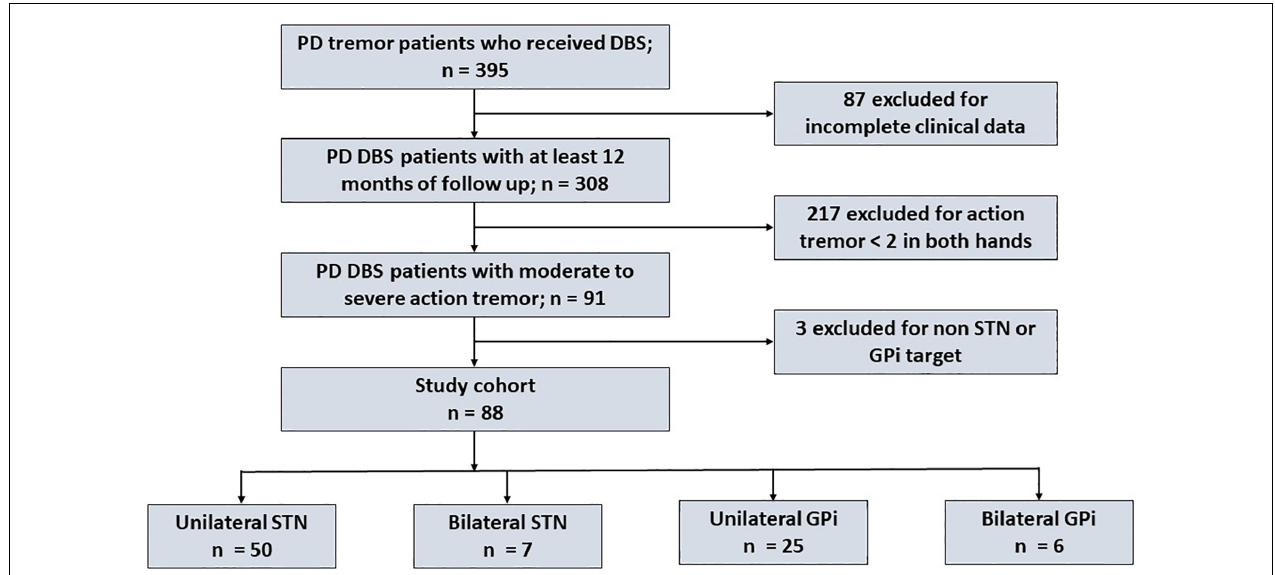
FIGURE 1 | Flow chart illustrating the patient selection process for our study cohort.